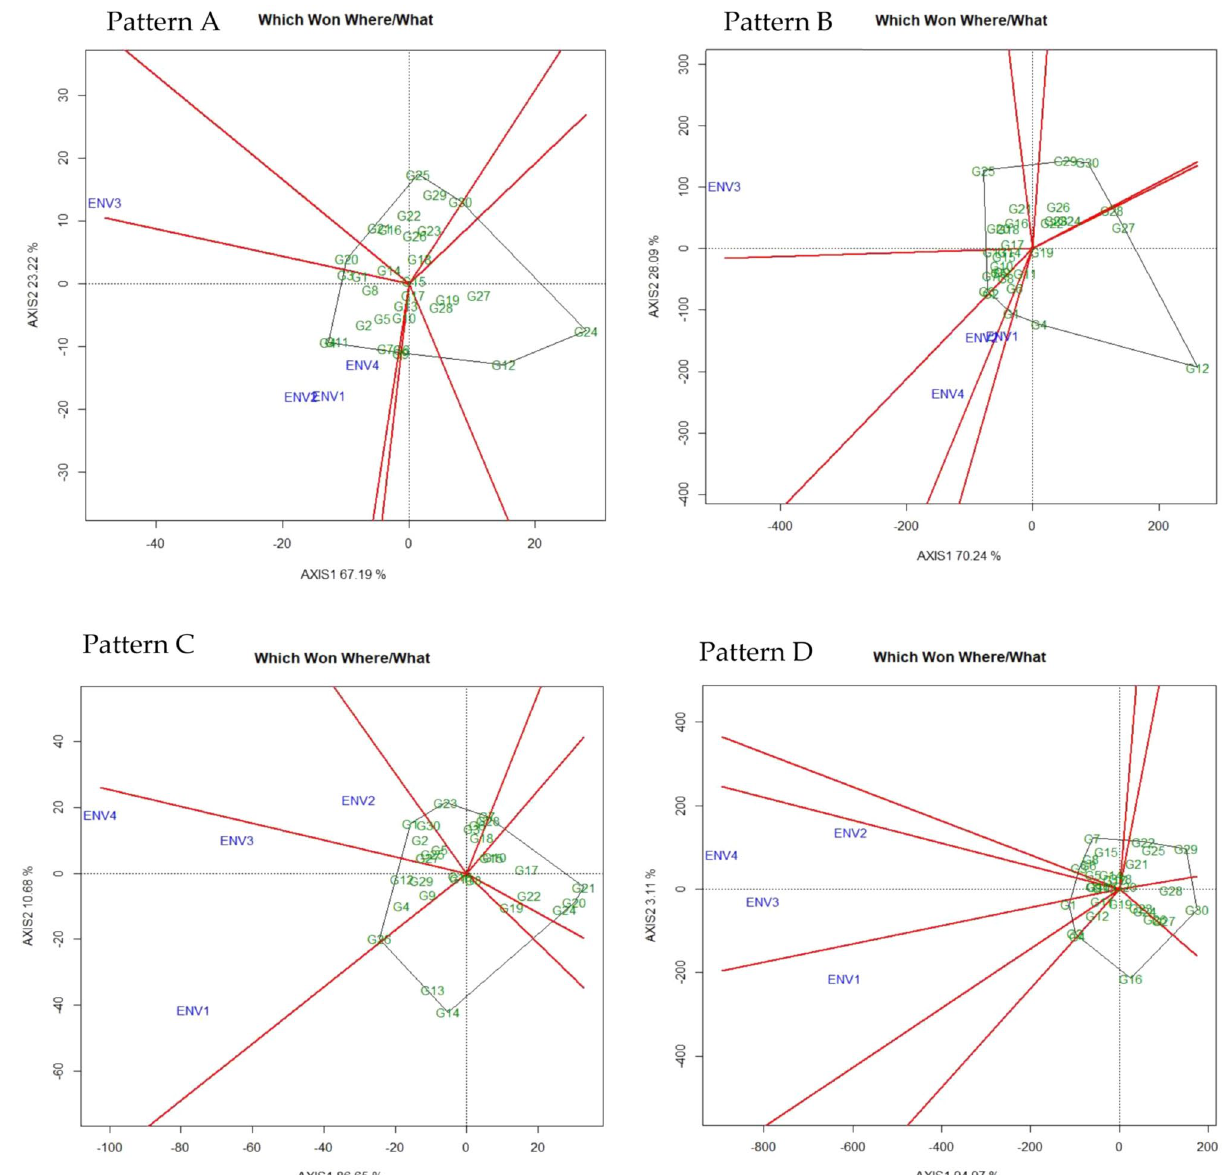
Figure 1. “Which-won-where” pattern of GGE biplot polygon view displaying the genotype main effect plus G × E interaction effect of 30 V . subterranea genotypes in two seasons two location for total number of pods (pattern A), fresh pod weight (Pattern B), hundred seed weight (Pattern C), yield per hectare (Pattern D). The biplots were based on Centering = 0, SVP = 2, Scaling = 0. The key to the genotype labels and the environmental description is given in Tables 1 and 2,